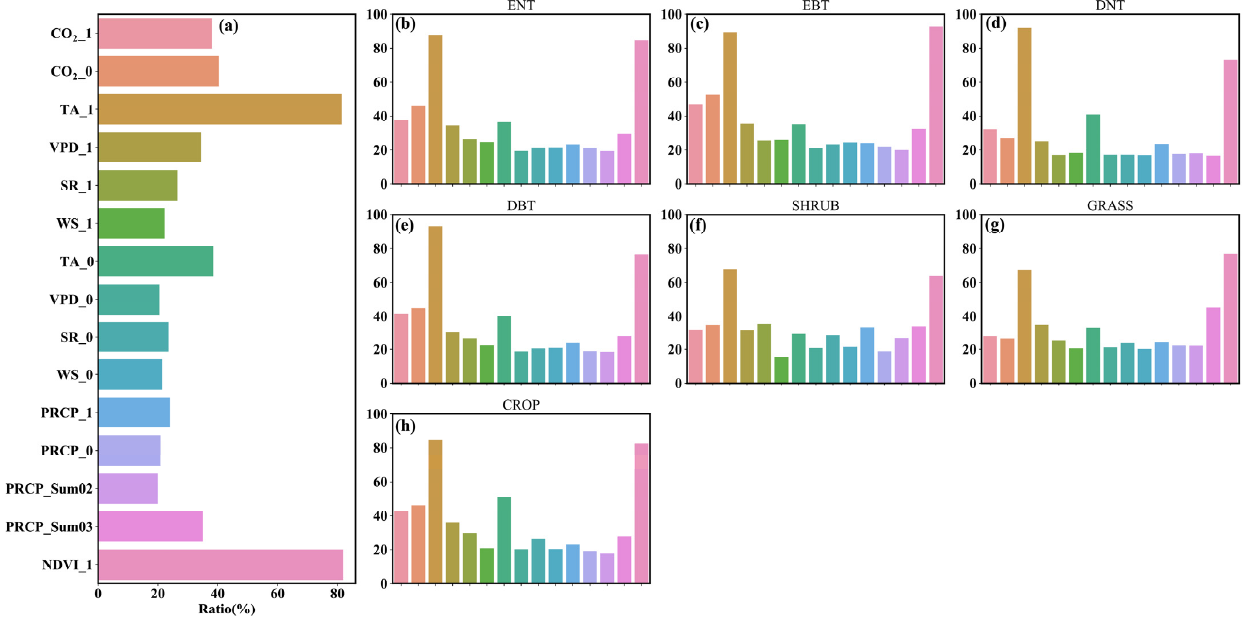
Figure 5. Relative importance of the selected explanatory variables for predicting the NDVI for ( a ) the entire study area and ( b – h ) the individual vegetation zones.